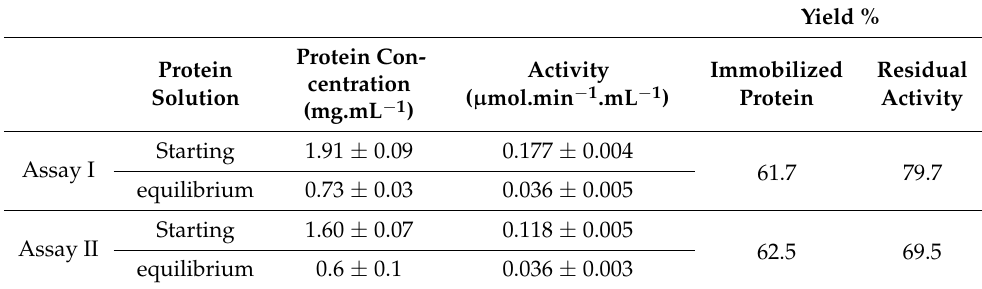
Table 2. Protein concentration of starting and equilibrium solutions (prepared with the crude enzyme extract) of two experiments of adsorption of CALB on Ns SiO 2 and yield percentage in terms of immobilized protein and residual hydrolytic activity in